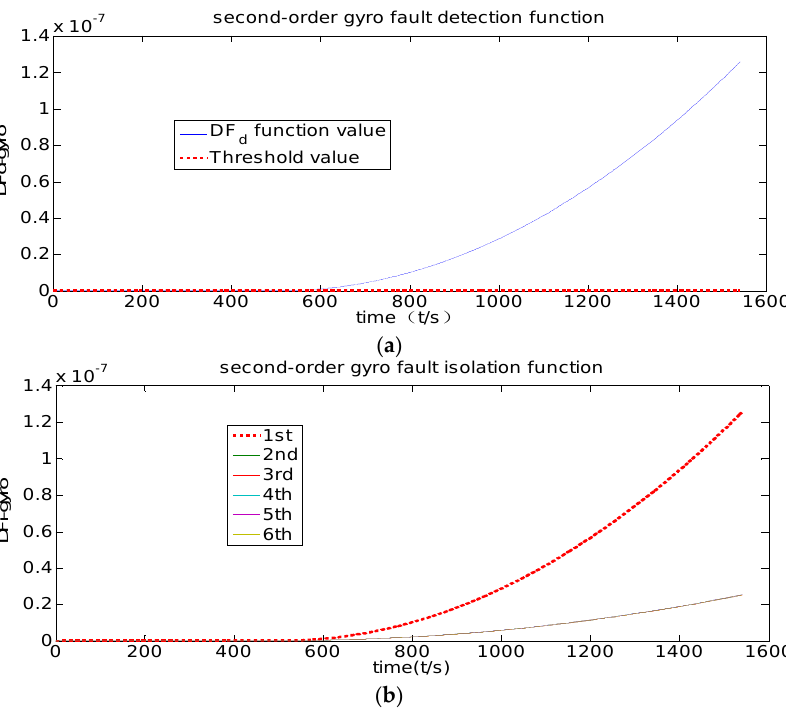
Figure 13. Second ‐ order channel filter. ( a ) Fault detection; ( b ) Fault isolation. Figure 13. Second-order channel filter. ( a ) Fault detection; ( b ) Fault isolation.